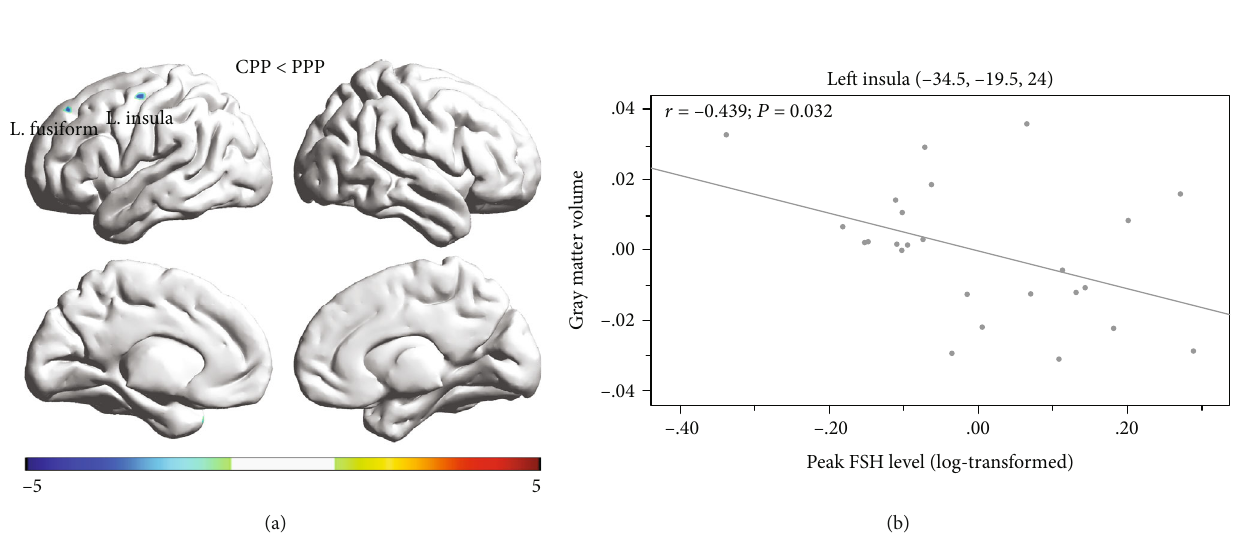
Figure 1: (a) Decreased gray matter density in central precocious puberty (CPP) vs. controls for the left insula and left fusiform overlaid on a 3D-T1 image in MNI space. All results shown are signi fi cant at P < 0 : 05 (FDR). (b) Central precocious puberty (CPP) group lower peak FSH level ( r = − 0 : 439 , P = 0 : 032 ) is associated with increased GMV in the left insula. Table 4: Regions of group di ff erences for seed-based functional connectivity